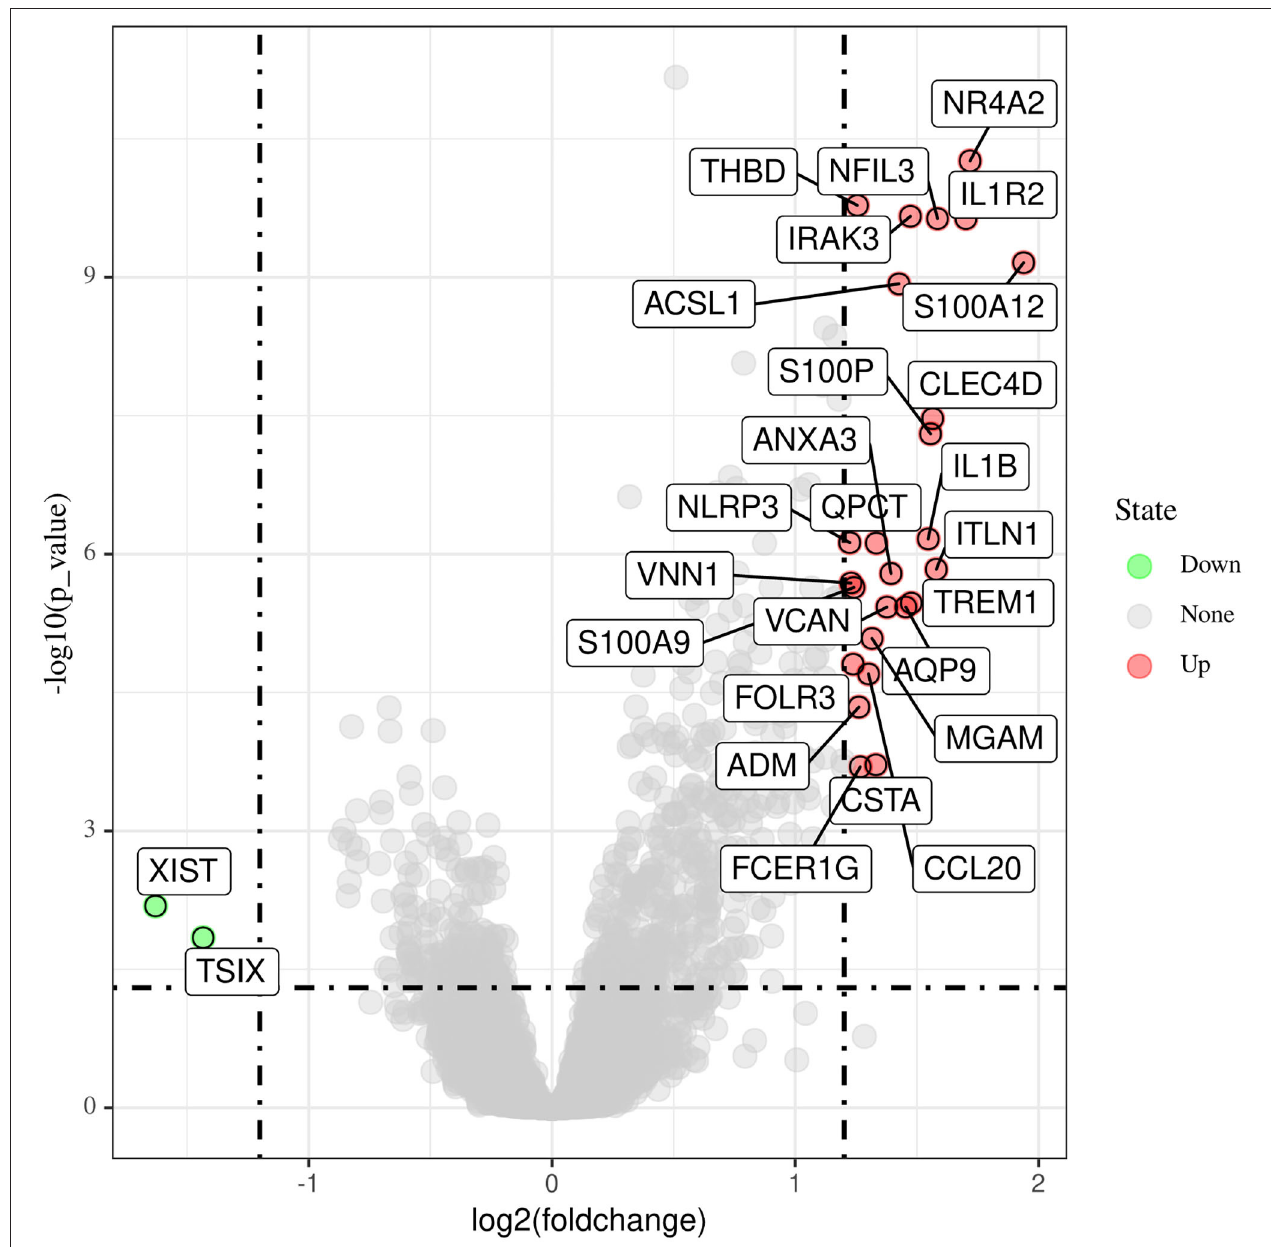
FIGURE 1 | Differentially expressed genes between acute myocardial infarction tissue and control